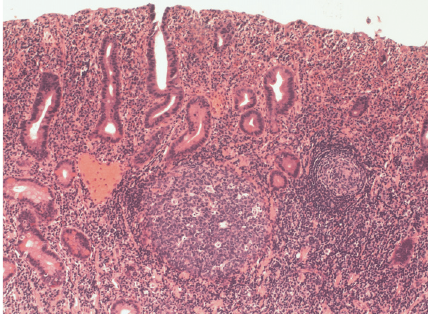
Figure 4: Haematoxylin and eosin (H&E) stain of small bowel tissue sample at low power (100x magnification) demonstrating expansion of the lamina propria by moderately increased chronic inflammation and reactive lymphoid hyperplasia with focal crypti- tis, villous blunting, and epithelial regenerative changes consistent with inflammatory pseudopolyps.